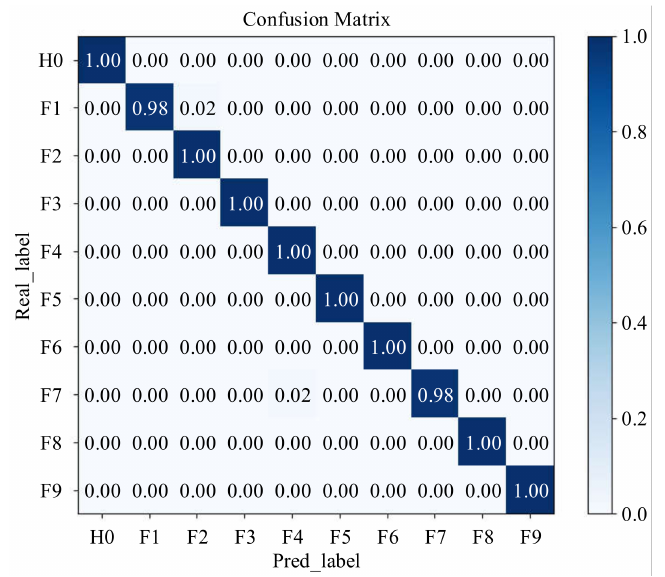
Figure 9. Confusion matrix demonstrating classification performance using testing data.